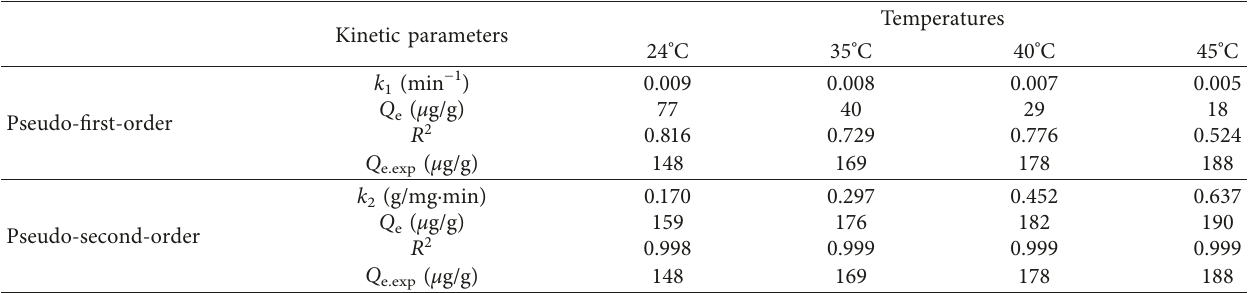
Figure 7: Linear representations of the pseudo-first-order kinetic model at different temperatures, pH � 9.6, V concentration � 5mg/L. Table 2: Pseudo-first-order and pseudo-second-order kinetic parameters at the different